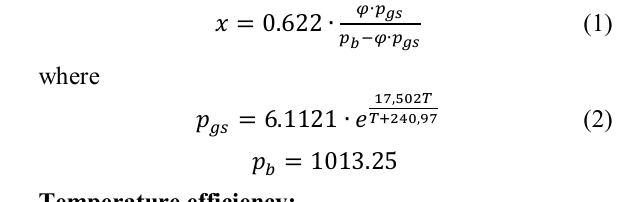
Table 1. Flow Conditions during the study.